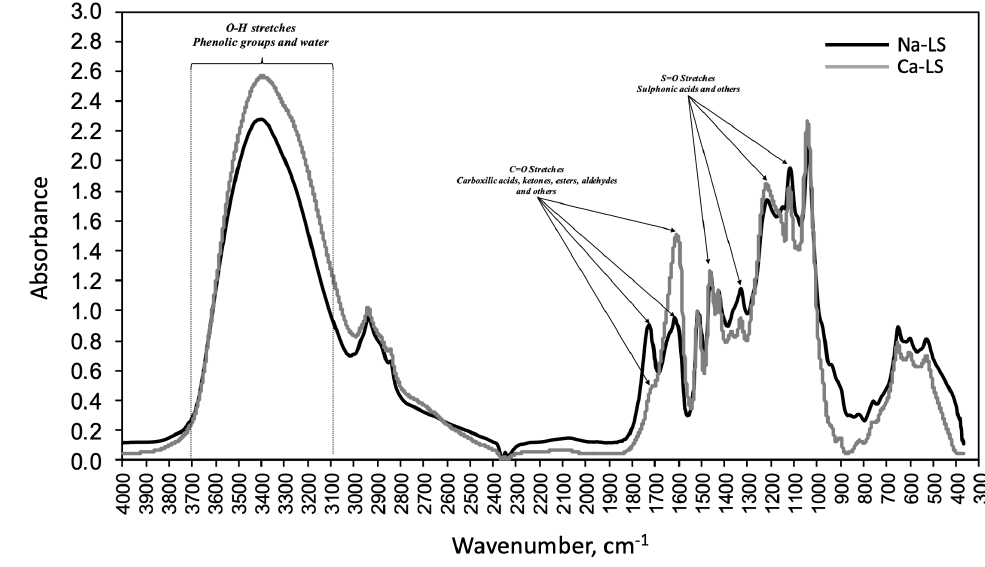
Figure 1. FTIR Spectra of samples Na-Ls and Ca-LS.